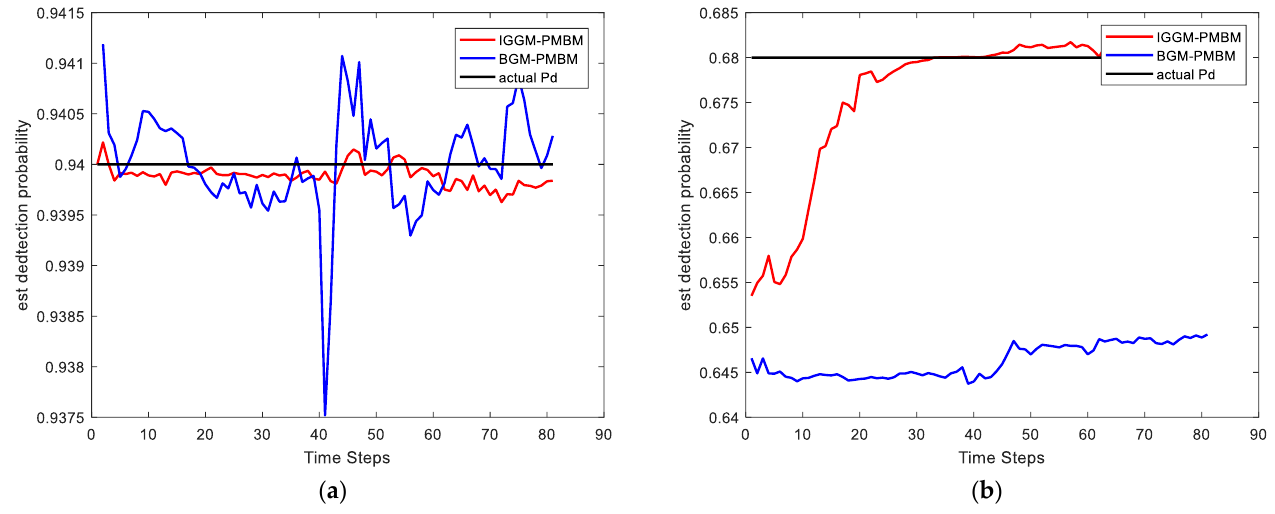
Figure 5. The standard deviation range value and the mean value of the estimated number of targets